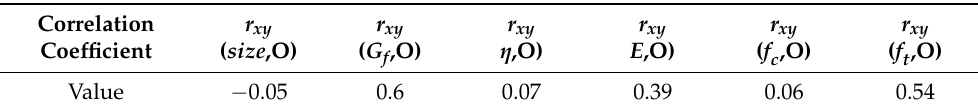
Table 11. Pearson’s correlation coefficient r xy values for individual input parameters and output parameter O (the objective